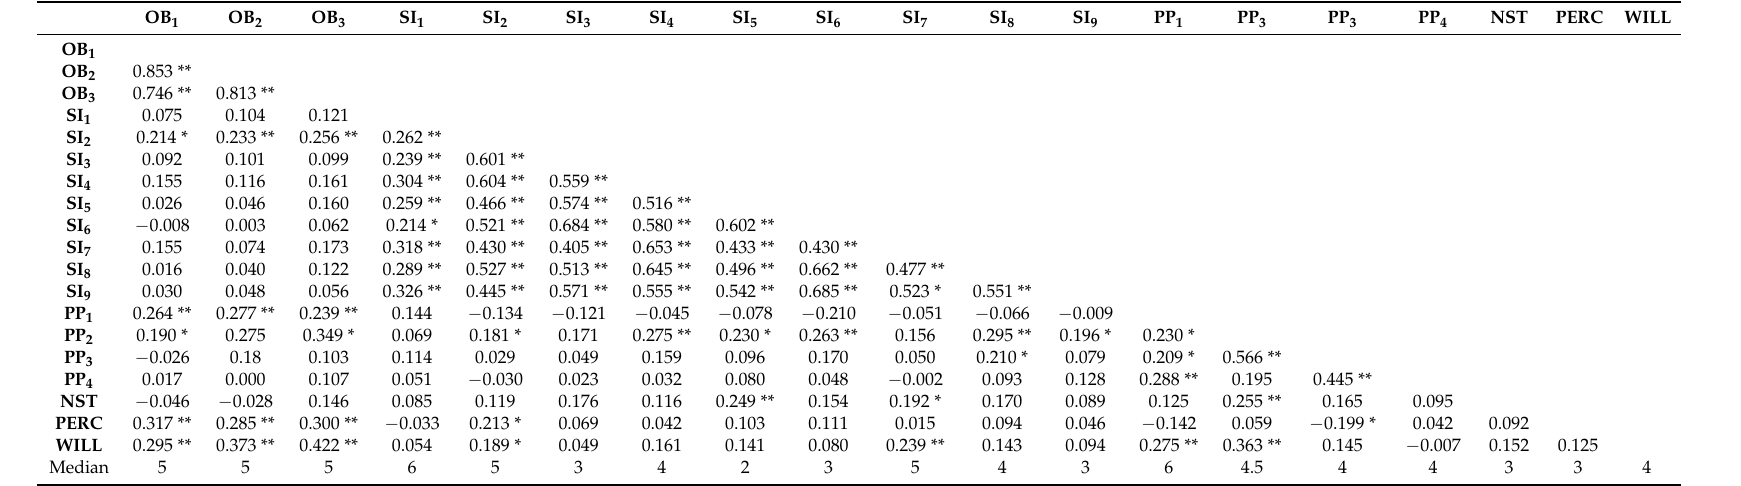
Table A1. Spearman correlation matrix among variables used in the structural model whereby * p < 0.05, ** p <